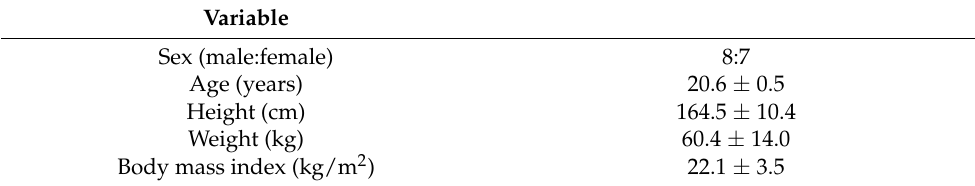
Table 1. The characteristics of the